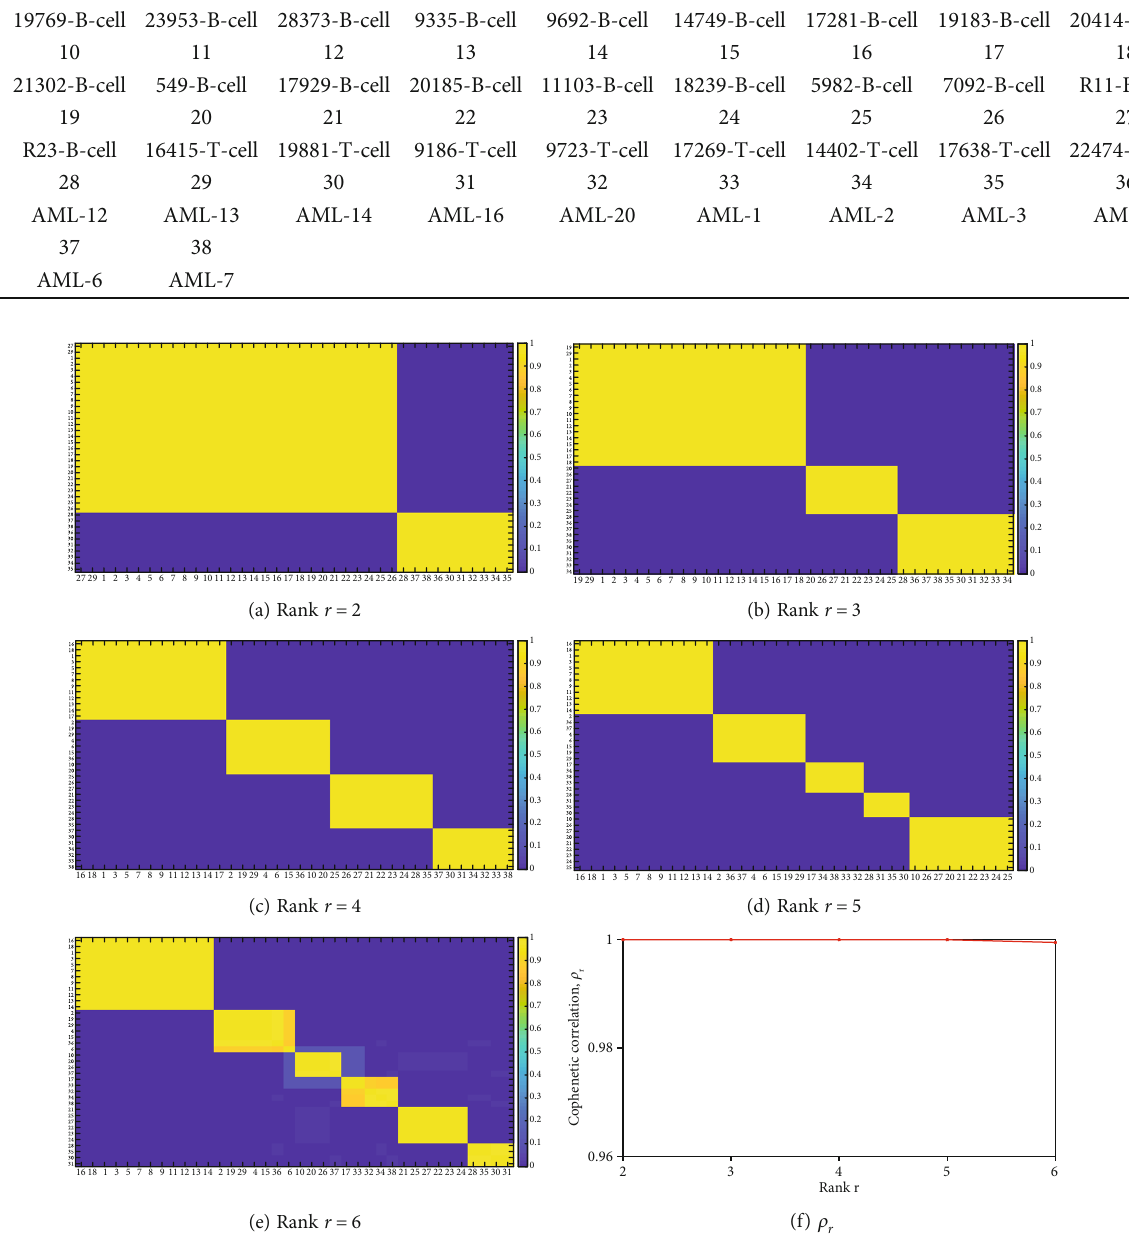
Figure 1: CDSNMF: (a – e) reordered consensus matrices and (f) cophenetic correlation coe ffi cient ρ